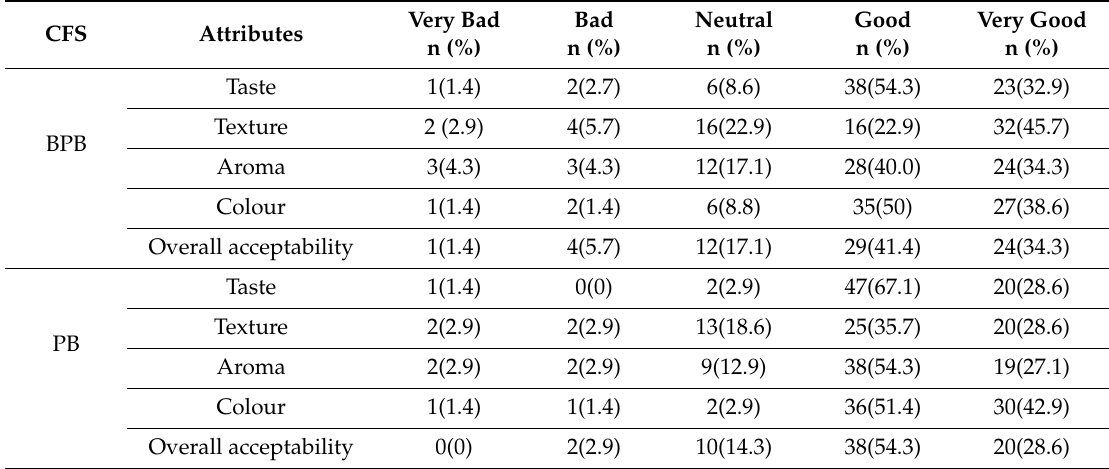
Table 4. The number and percentage of caregivers who gave the di ff erent ratings for the sensory attributes evaluated for BPB and PB ( N = 70).